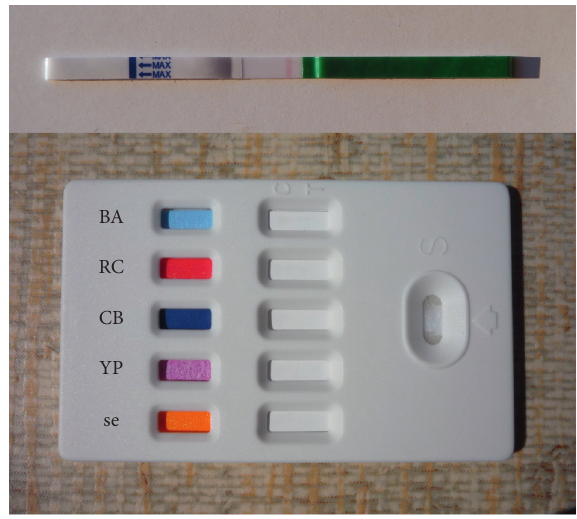
Figure 2: Appearance of commercial LFT devices. In the upper part, there is LFT for human chorionic gonadotropin; in the down part, there is a photograph of LFT for the contemporary deter- mination of five biological warfare agents Bacillus anthracis , ricin, Clostridium botulinum /botulinum toxin, Yersinia pestis , and staphylococcal enterotoxin B by Pro Strips (Advnt Biotechnologies, Phoenix, AZ,